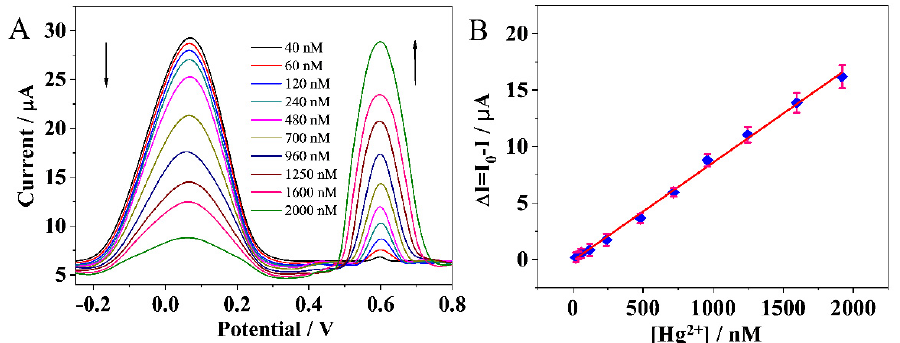
Figure 4. ( A ) DPVs and ( B ) corresponding calibration plot of Hg 2+ at the IIP/AuNPs/PCA ‐ rGO/SPCEs recorded in the potential range of − 0.3 V and +0.8 V (vs. pseudo ‐ Ag/AgCl), with 0.05 s modulation time, 0.2 s interval time, 60 mV modulation amplitude, 10.5 mV step potential, and 50 mV s ₋ 1 scan